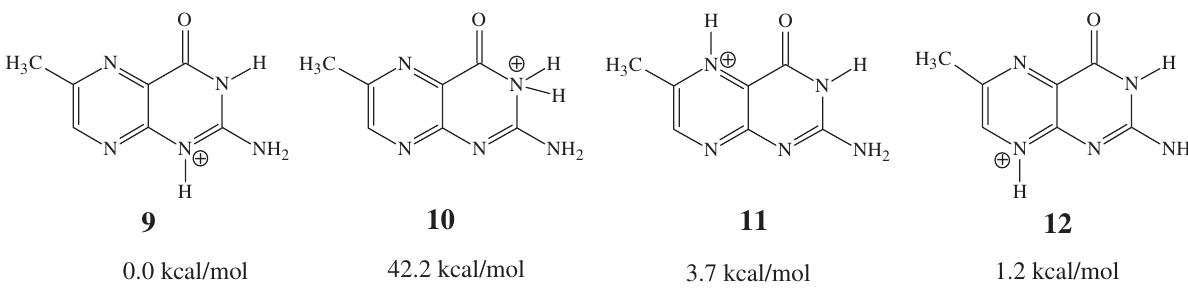
Figure 4 Relative calculated energies of pterins resulting from the ring nitrogen protonation of the lactam structure, 1 .